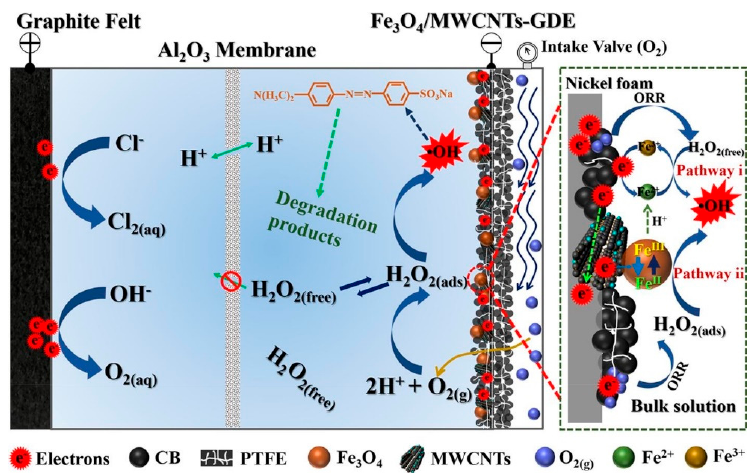
Figure 5. Schematic diagram of gas diffusion membrane cathode [114].